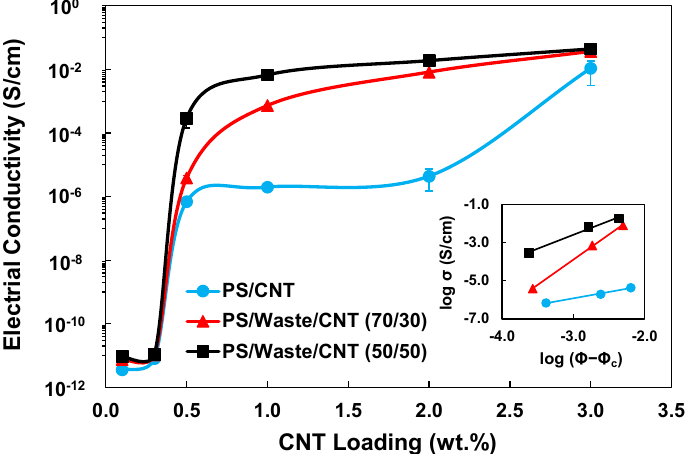
Figure 3. Electrical conductivity of PS/CNT and PS/Waste/CNT nanocomposites at CNT loadings of 0.1–3.0 wt.%, and PS/Waste weight ratio of 70/30 and 50/50. The inset shows the linear fitting of the percolation model (Equation (7)) to the electrical conductivity data. σ is electrical conductivity; Φ is filler volume fraction; Φ c is percolation threshold.